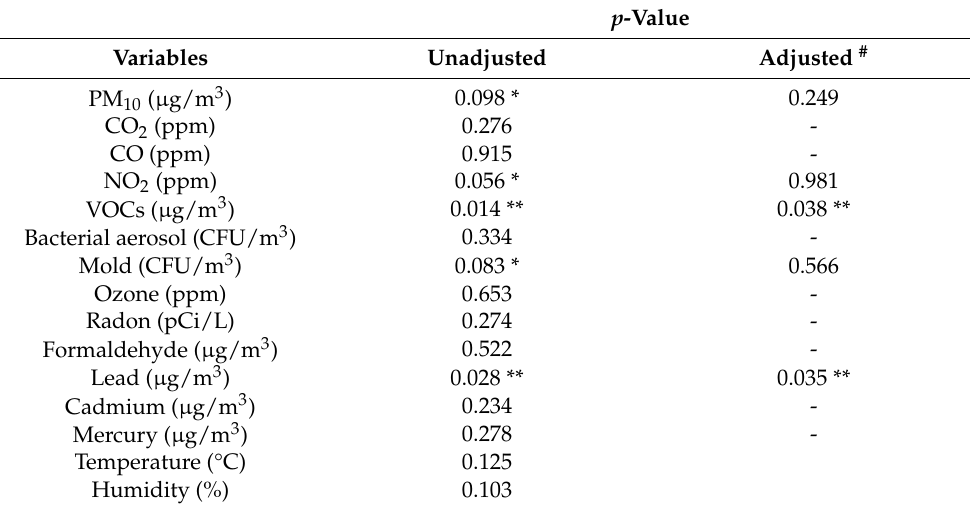
Table 2. Linear regression analysis considering the diagnosis of atopic dermatitis with dependent